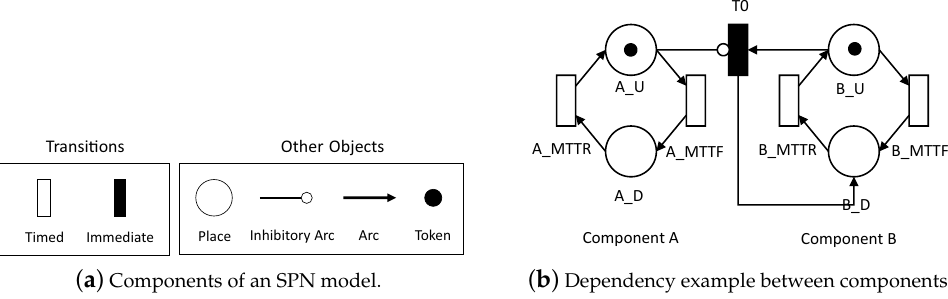
Figure 2. Basic elements in SPN models and captured behaviors of